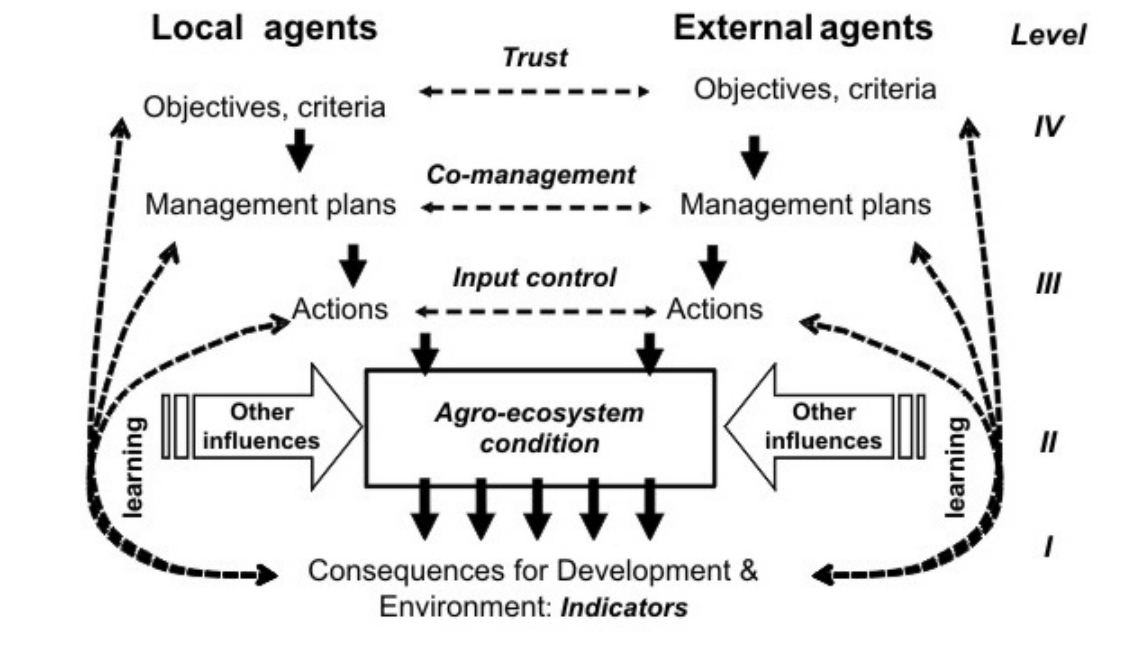
Fig. 1. Four levels of conditionality between local agents (ES providers and associated intermediaries) and external agents (ES beneficiaries and associated intermediaries) (modified from van Noordwijk et al.